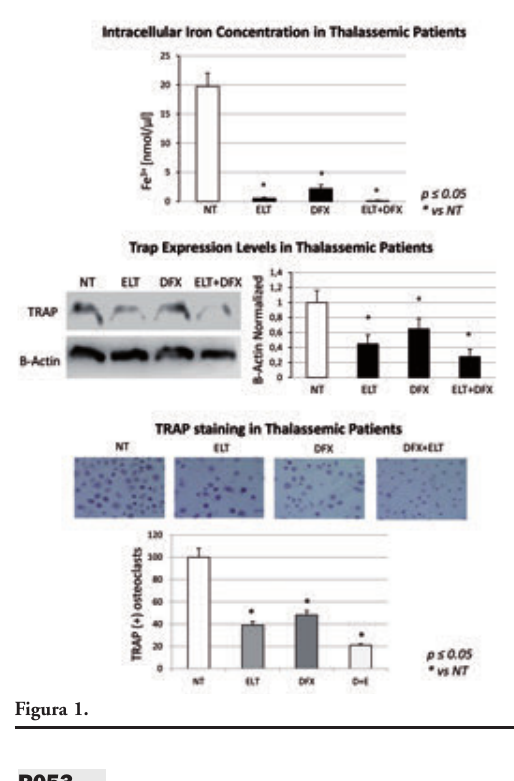
P053 QUANDO IL CUORE NON VA, E I NEUTROFILI NON CI